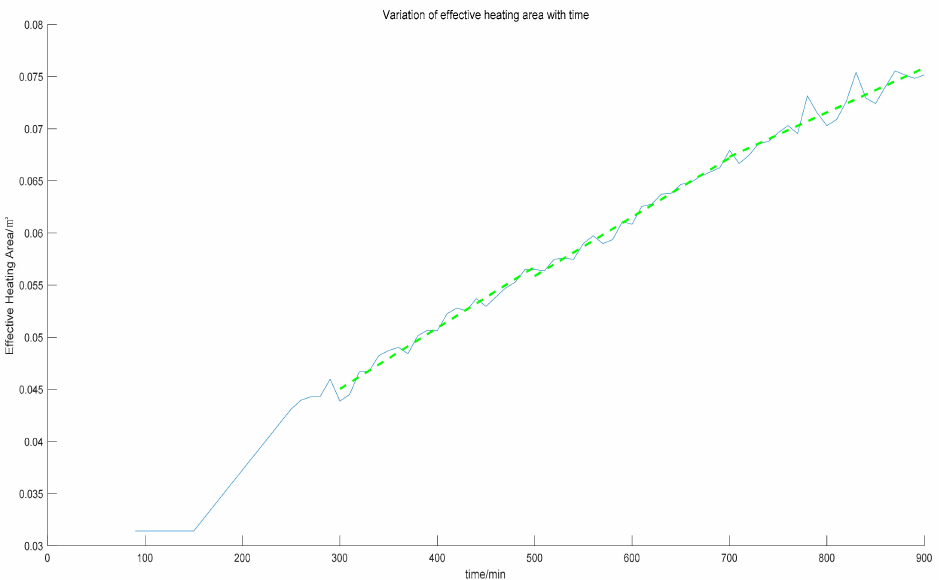
Figure 7. Variation curve of effective heating area versus time. Due to the problem of boundary accuracy, there are many fluctuations in the curve. The dotted line in the figure is the linear regression curve corresponding to interval